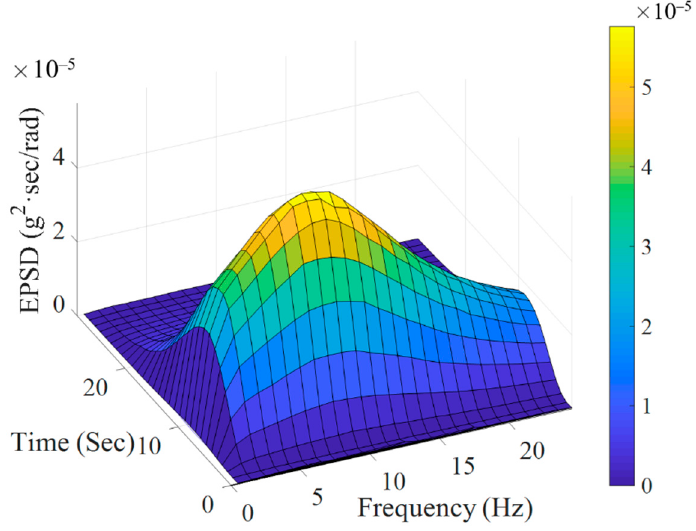
Figure 10. Reproduced EPSD.